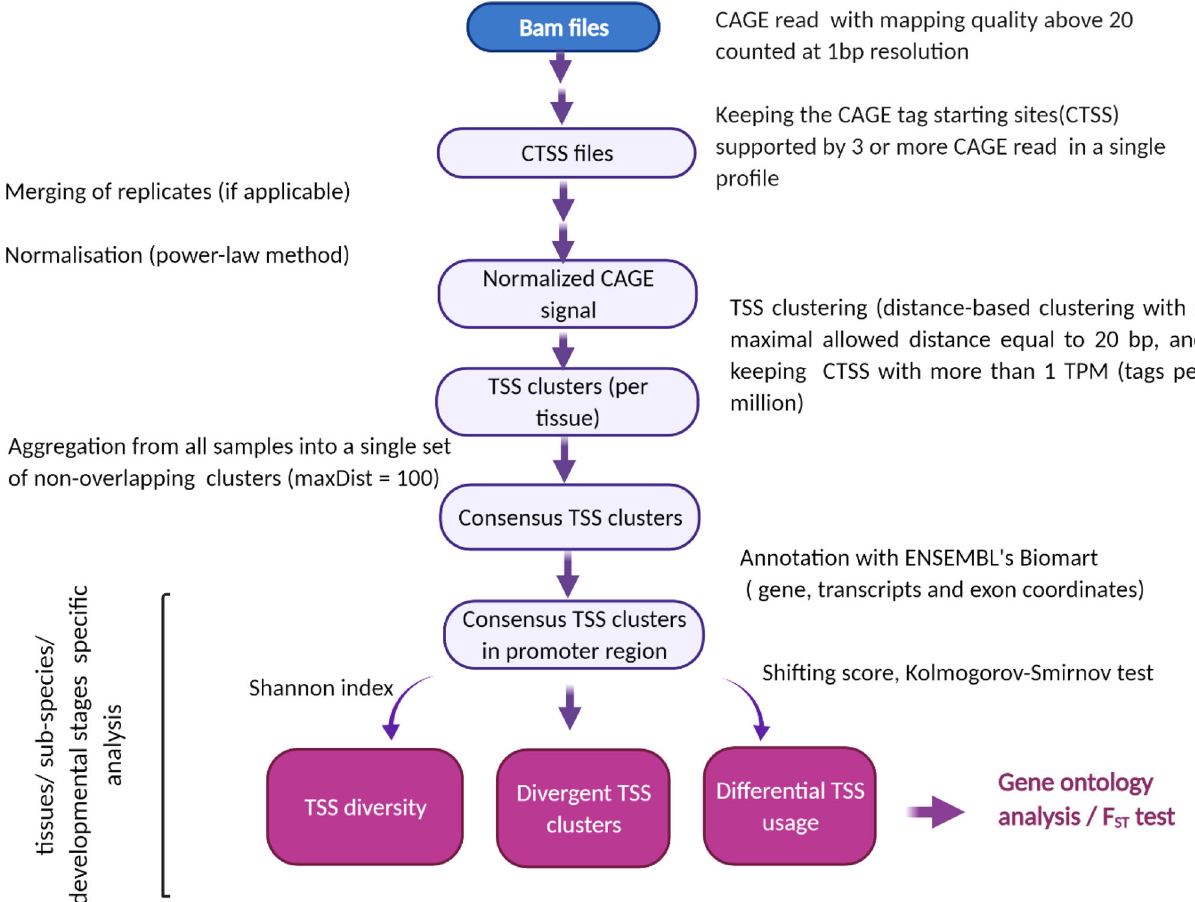
Fig. 1 Flow chart of main steps in TSS identi fi cation. CAGE-seq signals were normalized based on power-law method after doing some quality control for bam and CTSS fi les. Then TSSs were called using distance-based clustering methods and aggregated into a consensus TSS clusters. Eventually, different properties of TSSs were assessed after annotating consensus TSS cluster with